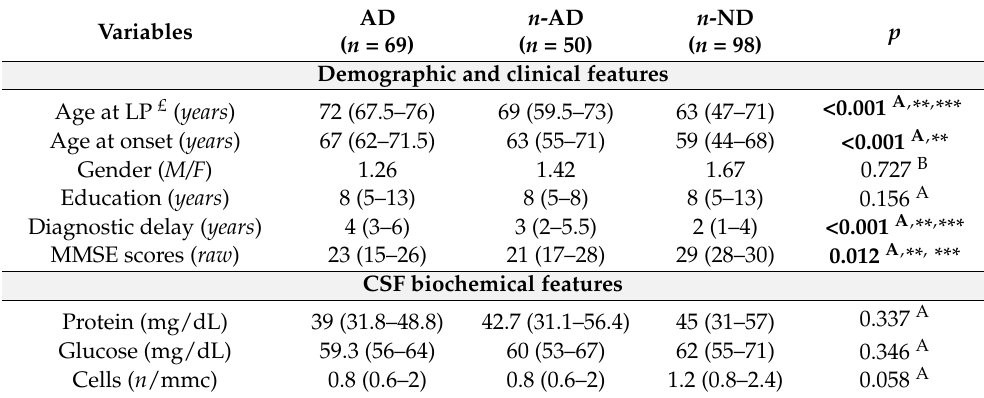
Table 1. Demographic, clinical and CSF features of patients with Alzheimer’s disease (AD), patients with other neurodegenerative disorders ( n -AD) and patients with non-neurodegenerative disorders ( n -ND). Data are expressed as medians with interquartile ranges (IQRs).